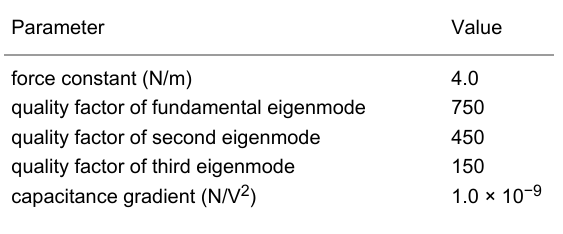
Table 1: Typical values used for the cantilever parameters in the simu- lations reported